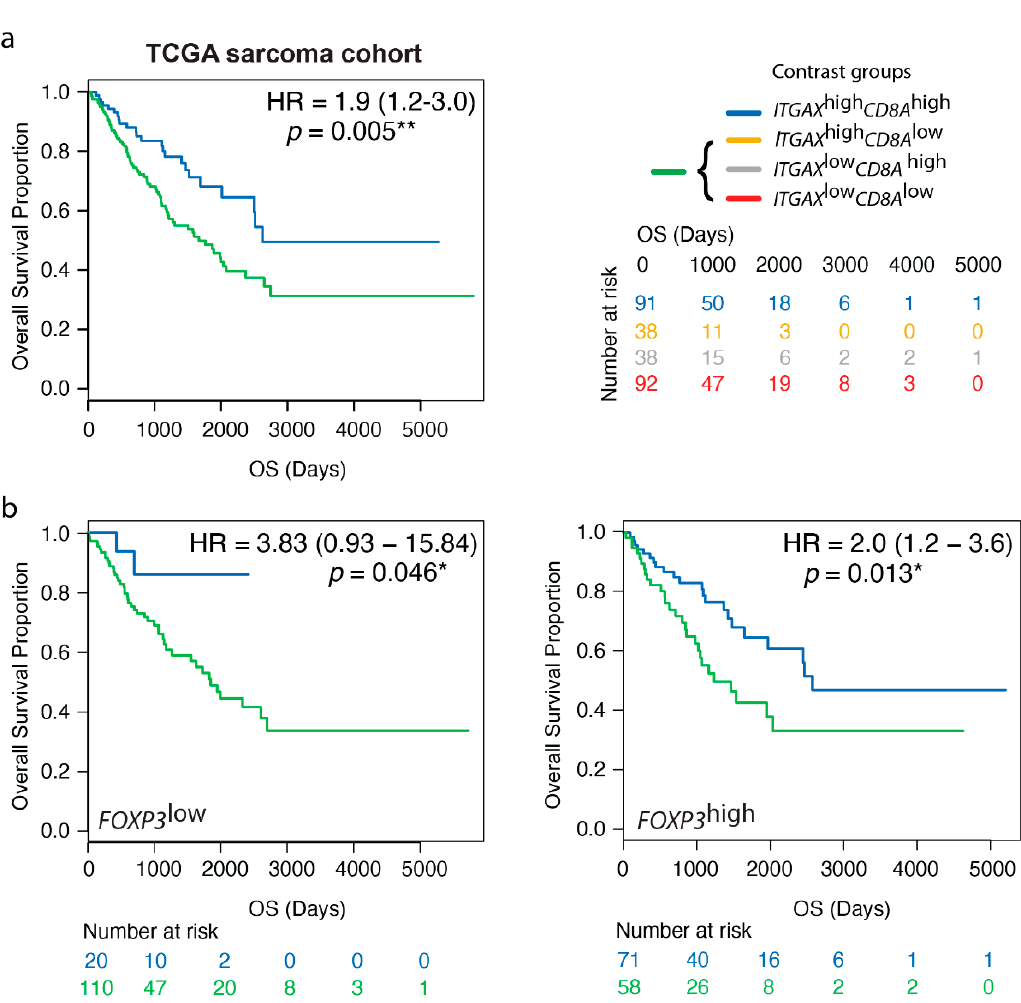
Figure 4. High gene expression levels of ITGAX together with CD8A are prognostic by transcriptomics, irrespective of FOXP3 levels, in human STS. ( a ) Contrast group analysis of gene expression levels of ITGAX (CD11c) and CD8A (CD8) in the TCGA sarcoma cohort; ( b ) Contrast group analysis of gene expression levels of ITGAX (CD11c) and CD8A (CD8) in the TCGA sarcoma cohort where FOXP3 low and FOXP3 high indicate subgroupings according to total FOXP3 levels in the TME. * p < 0.05, ** p < 0.01; p < 0.05 is considered